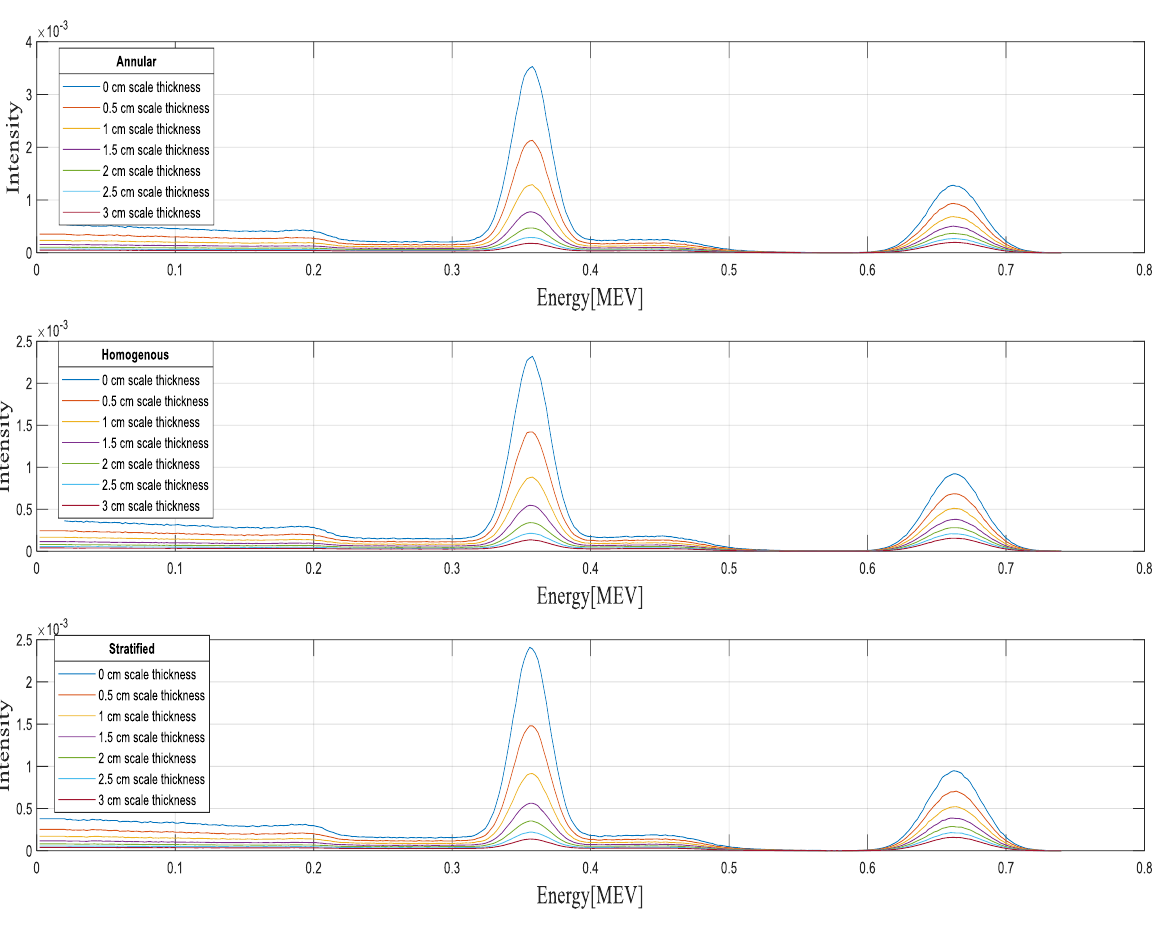
Figure 3. Signals recorded by the detector for three modelled patterns at 40% void fraction and different scale thicknesses.